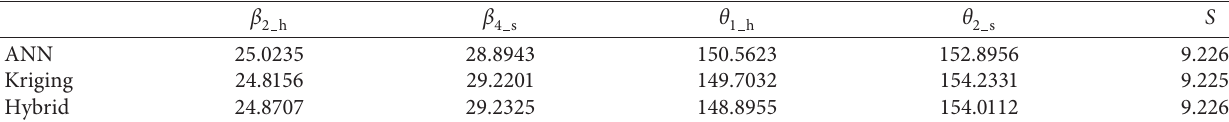
Figure 14: Fitting accuracy of composite model. Table 11: Optimization results of different surrogate model.